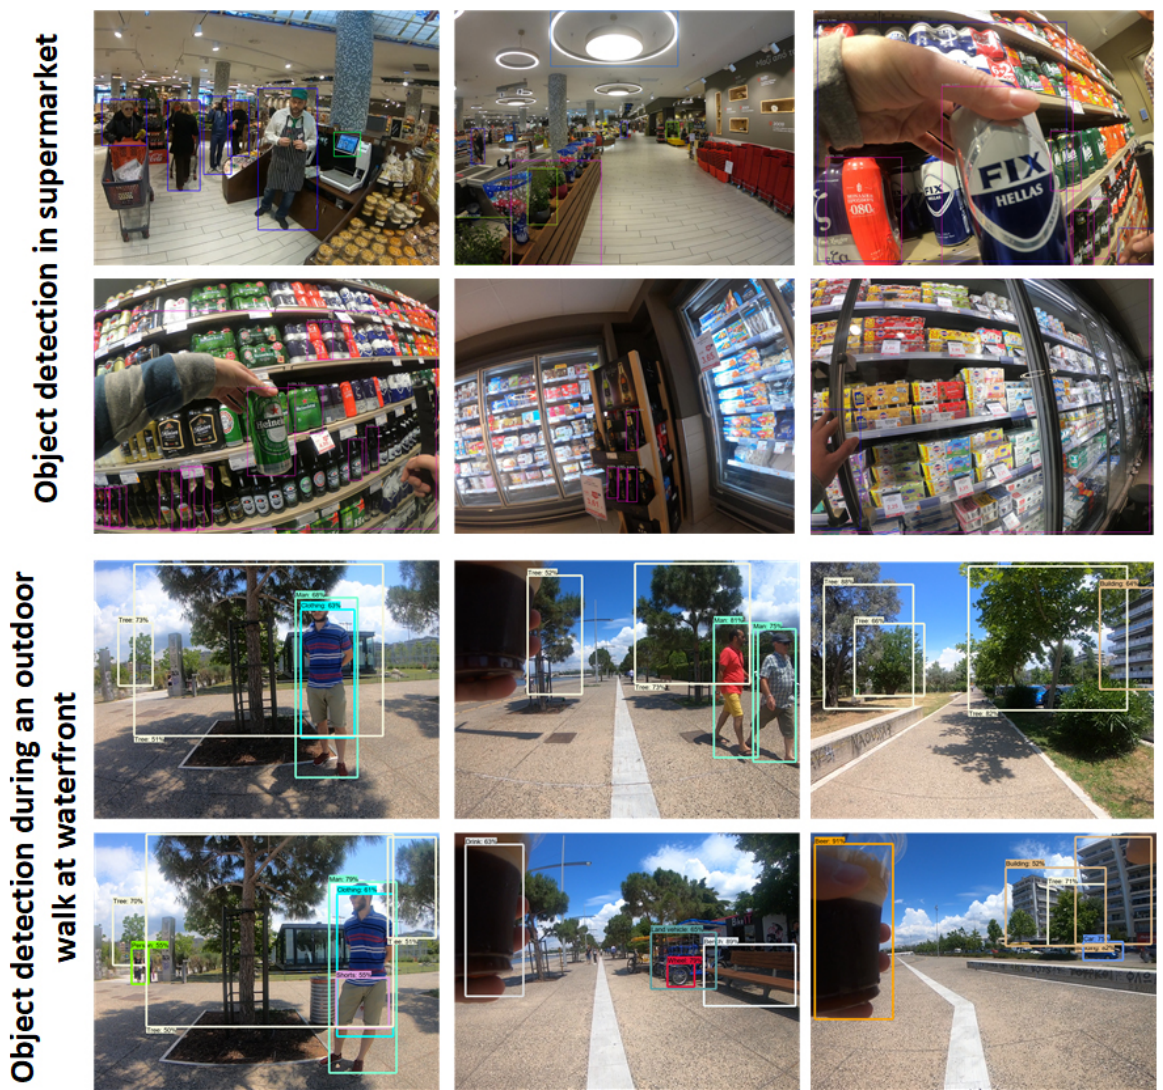
FIG. 3 Object recognition in exemplar images (egocentric viewpoint) during a visit in supermarket and an outdoor